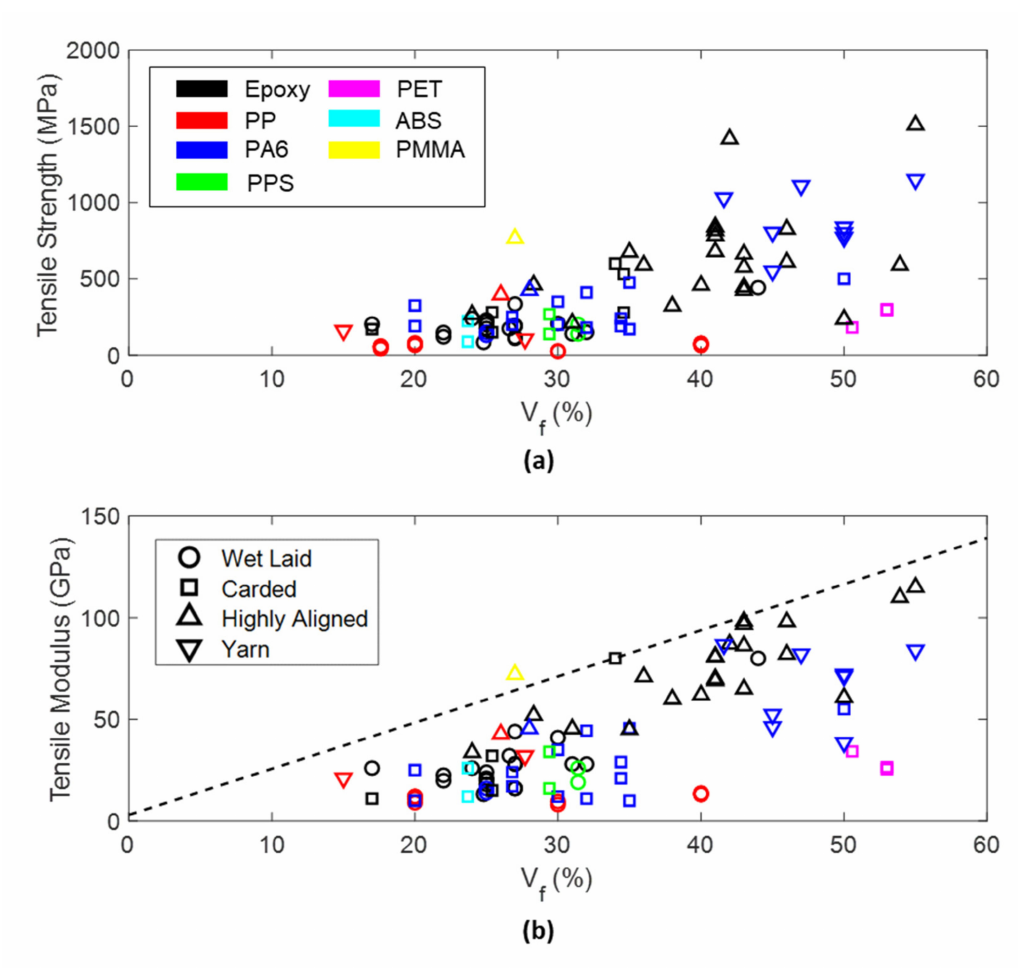
Figure 10. Tensile strength ( a ) and modulus ( b ) as a function of fiber volume fraction. Dashed line represents the Rule of Mixtures estimation for longitudinal modulus in unidirectional